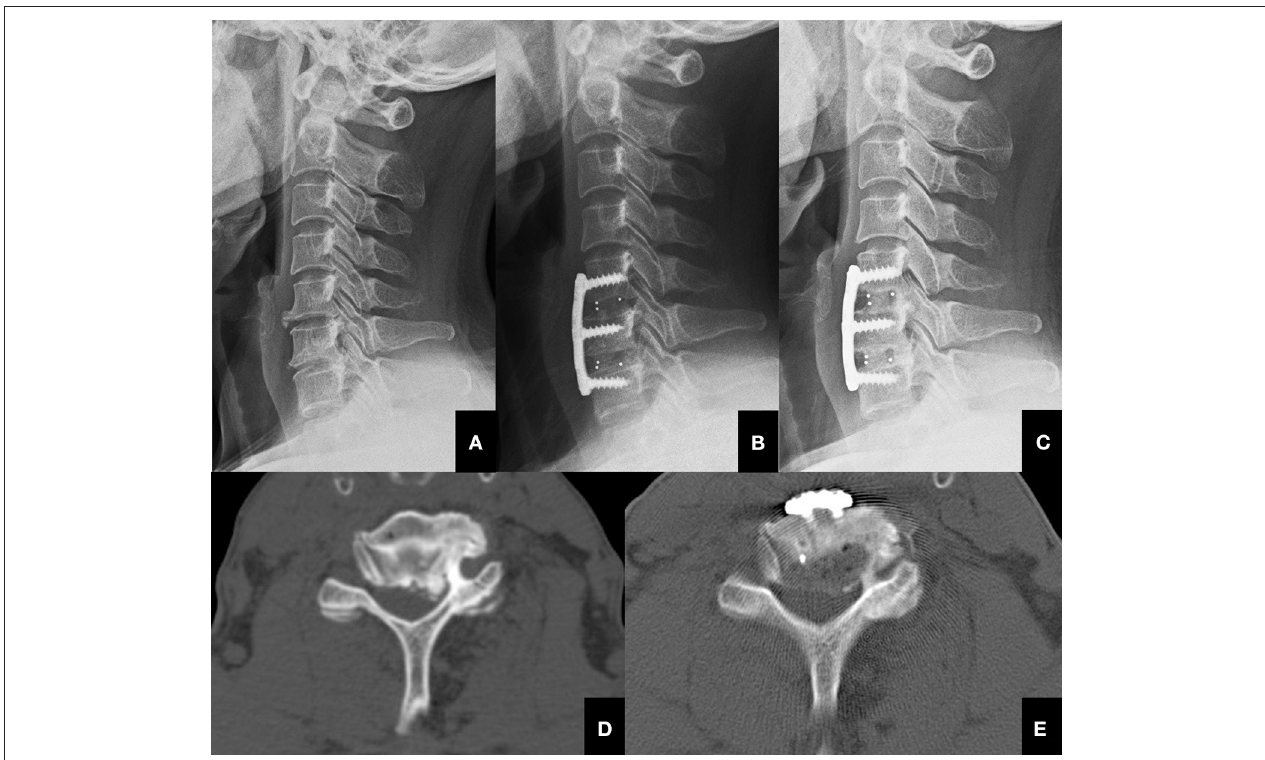
FIGURE 2 | The process of performing UPR. (A) Typical lateral pre-operative X-ray image of a 56-year-old female patient with cervical radiculopathy ready to receive ACDF + UPR treatment. (B) Post-operative lateral X-ray image of the patient that received ACDF + UPR treatment. (C) One-year post-operative lateral X-ray image of the patient that received ACDF + UPR treatment, and showed spinal fusion was achieved and cervical alignment was sustained. ( D) Pre-operative CT image showing severe hypertrophied left uncinate process of C5-C6 level. (E) Post-operative CT image showing the resected uncinate process of C5-C6 level.